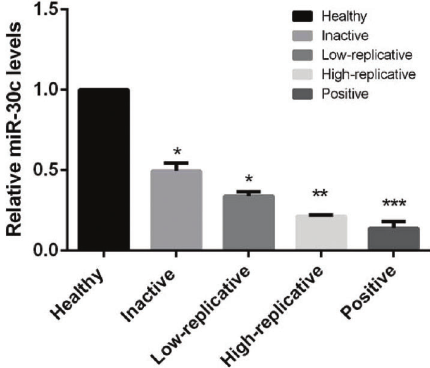
Figure 1. Serum levels of miR-30c in healthy controls and hepatitis B virus (HBV) carrier patients with inactive, low-replicative, high- replicative and HBe antigen-positive chronic hepatitis B. Data are reported as means ± SD. *P o 0.05, **P o 0.01, ***P o 0.001 com- pared to healthy controls